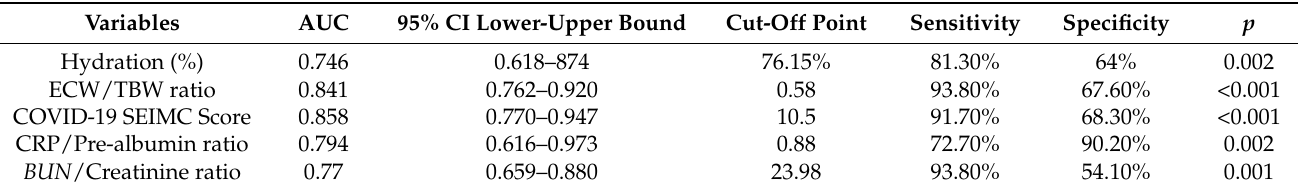
Table 3. Analysis of the prognostic factors of mortality in COVID-19.